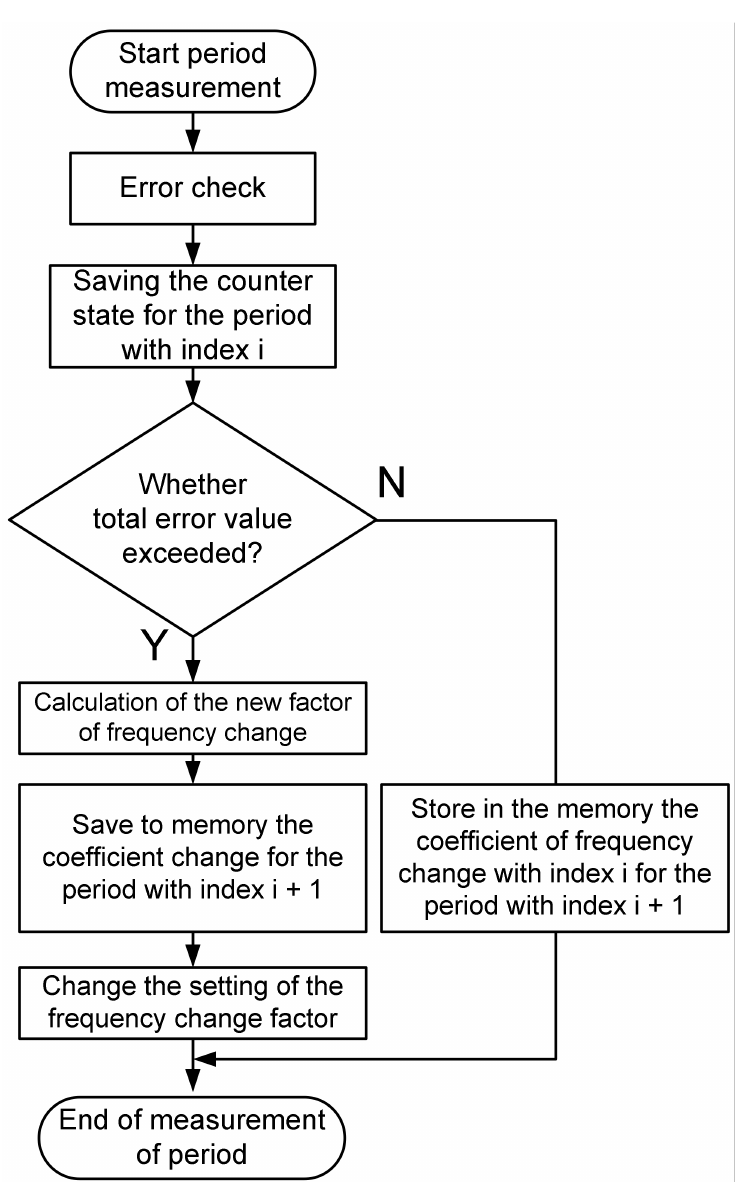
Figure 8. Work algorithm of the f/N converter containing a microprocessor system with low